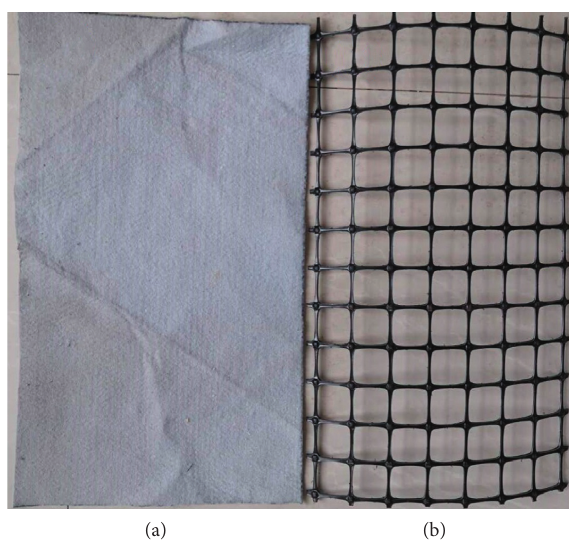
Figure 3: The geogrid used in the test: (a) geotextiles and (b) geogrid.